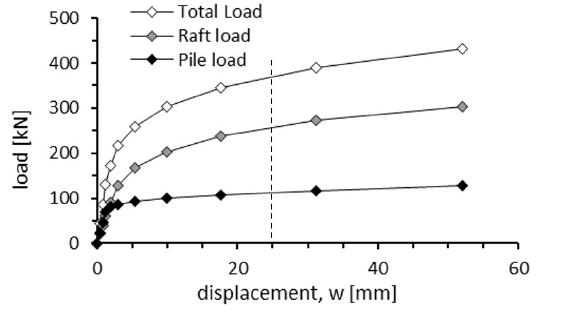
Figure 18. Load-settlement curves for case 11 - L=5m; t=0.3m